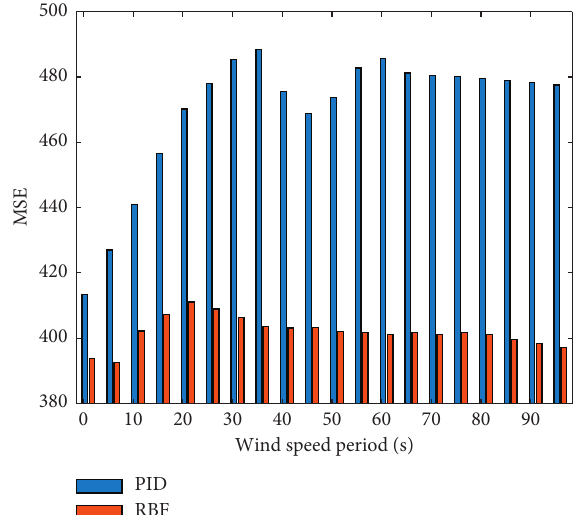
Figure 9: Evolution of error for different periods of the sinusoidal wind